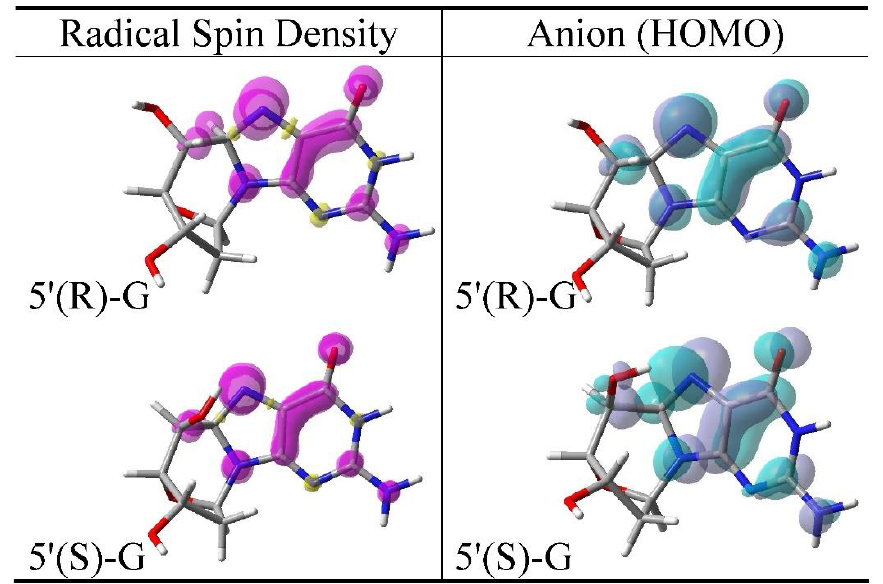
Figure 2. The ωB97XD-PCM/6-31++G**-calculated Mulliken spin density distribution of (i) 5′(R),8- cyclo-2′-deoxyguanosine-7-yl radical and (ii) 5′(S),8-cyclo-2′-deoxyguanosine-7-yl radical (left col- umn) and HOMO of one-electron reduced radicals (anions) (right plot). Spin density and HOMO are calculated at 0.004 and 0.04 electron/bohr 3 , respectively. Table 4. The ωB97XD-PCM/6-31++G**-calculated relative free energies (ΔG), relative populations based on Boltzmann distribution, electron affinities, and one-electron reduction potential (E°) of two isomers of 5′,8-cyclo-2′-dG.